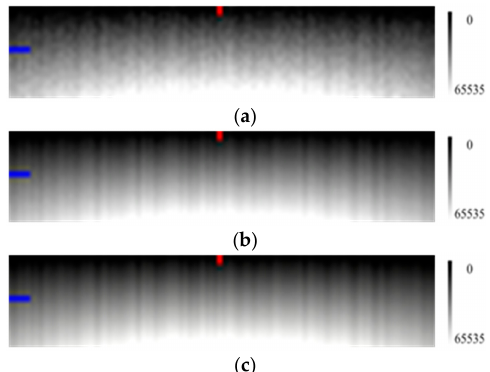
Figure 3. Simulated calibration images (100 samples × 20 lines) using various numbers of measurements with the horizontal direction for the pixels and the vertical direction for the radiance level (the radiation energy is gradually enhanced from the top to the bottom as the right grayscale). ( a ) measurement conducted once; ( b ) measurements conducted 20 times; and ( c ) measurements conducted 100 times. Column 50 and line 10 are respectively marked with red and blue labels.